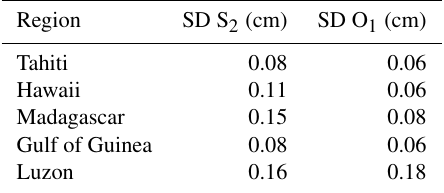
Table A1. Spatial-mean SD of models for S 2 and O 1 tide compo- nents for each studied region (in